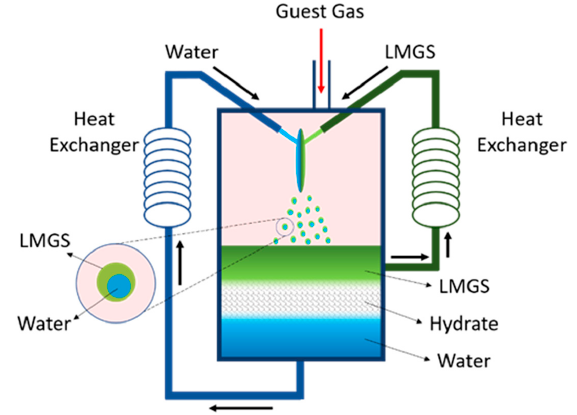
Figure 6. Conceptual illustration of a twin-jet hydrate-forming system.